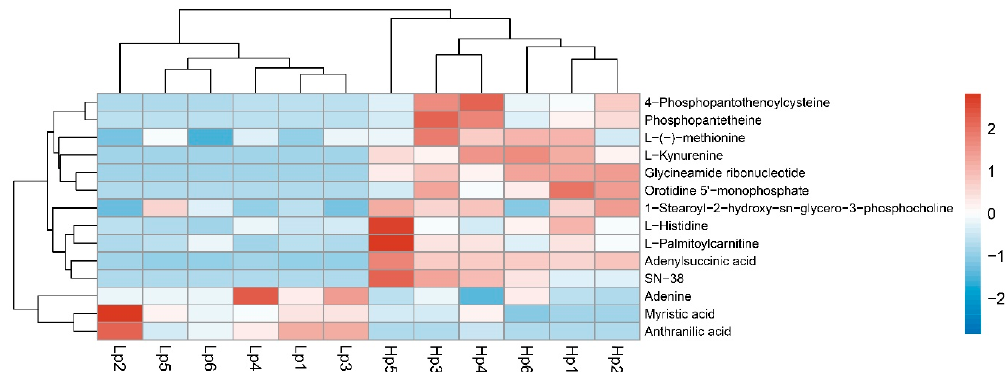
Figure 7. Heatmap of the differential metabolites of high-altitude compared to low-altitude B. pyrosoma . Hp represents high-altitude B. pyrosoma samples, Lp represents low-altitude B. pyrosoma samples, and the Arabic numerals indicate each sample.